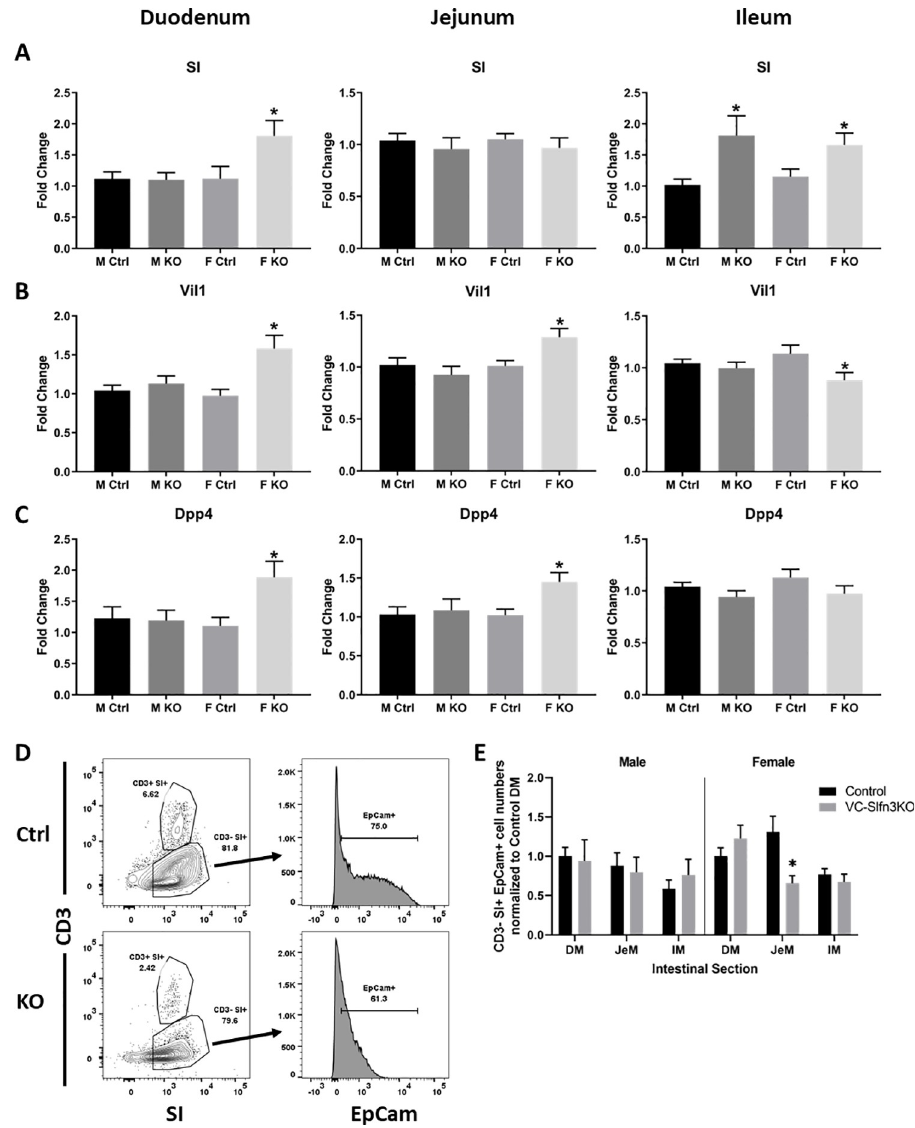
Fig 5. Intestinal differentiation markers SI, Vil1, and Dpp4 vary expression due to intestinal epithelial specific loss of Slfn3, intestinal region, and sex. Total RNA was isolated from intestinal mucosa of the duodenum, jejunum, and ileum of control (Ctrl) and VC-Slfn3KO (KO) mice. The mRNA expression of (A) SI, (B) Vil1, and (C) Dpp4 was analyzed by qPCR using RPLP0 as a reference control gene. (n = 9–50, � p < 0.05 to respective Ctrl). Single cell suspension of intestinal cells from the duodenum, jejunum, and ileum were analyzed by flow cytometry in Ctrl and VC-Slfn3KO mice. (D) Representative dot plot gating on CD3 - SI + from jejunal intestinal cells were then further gated on EpCam + cells by histogram. (E) CD3 - SI + EpCam + cells were normalized to control duodenum cell numbers within each experiment and by sex. (male n = 14–15, female n = 9–14; � p < 0.05 to respective Ctrl).